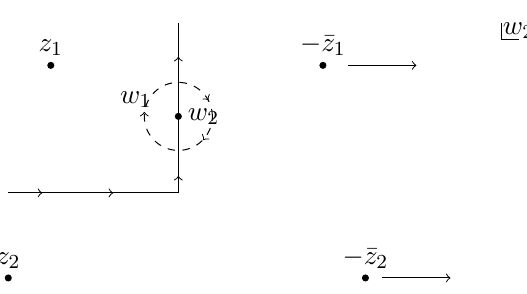
Figure 17 . Contours of integration responsible for the value of T L at order g 2 . The integrand is proportional to Res z = w h (cid:27) ( z 1 ; (cid:22) z 1 ) T ( z ) (cid:27) ( z 2 ; (cid:22) z 2 ) (cid:15) ( w 1 ; (cid:0) w 1 ) (cid:15) ( w 2 ; (cid:0) w 2 ) i . The dashed circle is the 2 contour of integration in w 1 , which picks up the pole at w 1 = w 2 . Finally, the solid line is the contour of integration in w 2 . The singularities at w 2 = z 1 ; z 2 ; (cid:0) (cid:22) z 1 ; (cid:0) (cid:22) z 2 are poles for the (cid:12)nal integrand, even before taking the D ! 1 limit, whose e(cid:11)ect on the position of (cid:22) z 1 and (cid:22) z 2 is illustrated by the